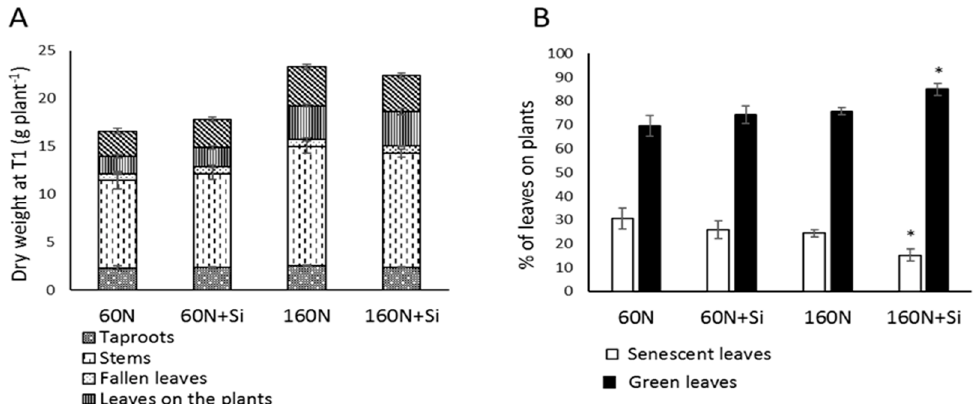
Figure 2. Compartment and total biomasses ( A ) and percentage of green and senescent leaves ( B ) of rapeseed plants harvested at T1 (G1 stage). Plants were grown in lysimeters with 60 (60 N) or 160 kg of N ha − 1 (160 N) and supplied with or without Si (12 kg ha − 1 : 60 N + Si and 160 N + Si). Values correspond to the mean ± SE for n = 3. The data obtained from plants treated with silicon (60 N + Si and 160 N + Si) were compared to their respective controls. * indicates a significant difference at p ≤ 0.05.